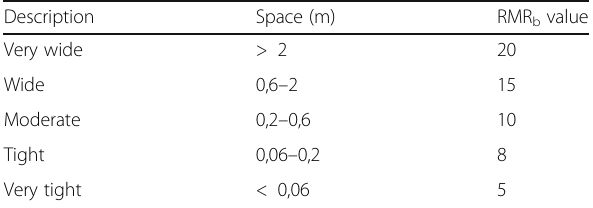
Table 3 The space of discontinuous planes